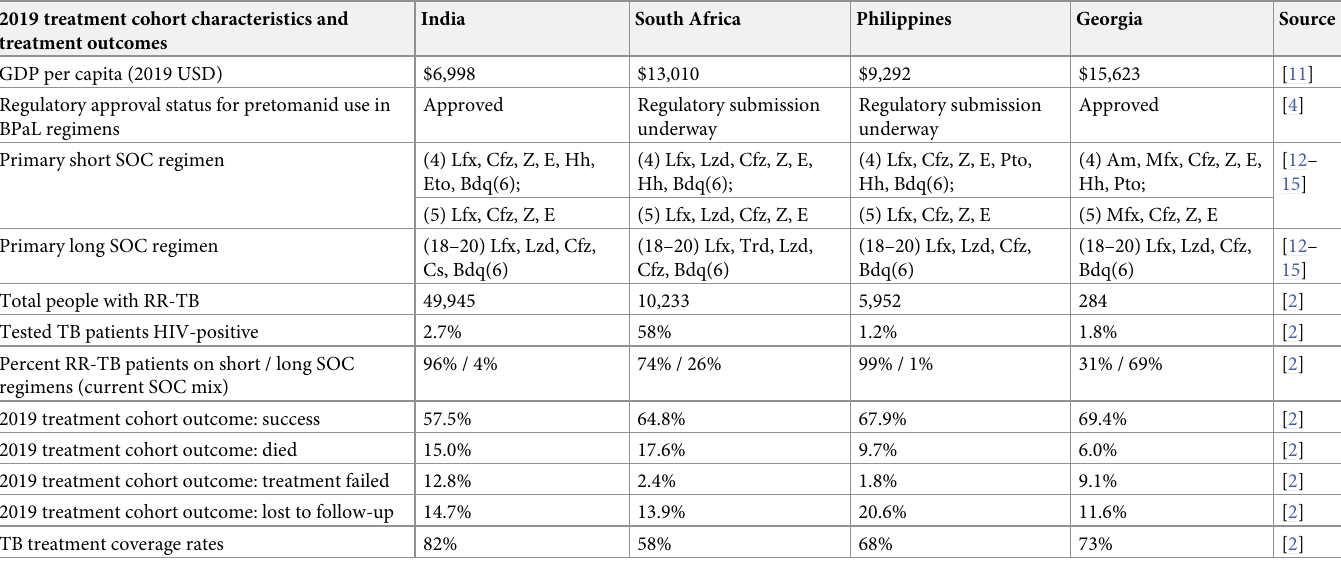
Table 1. Country